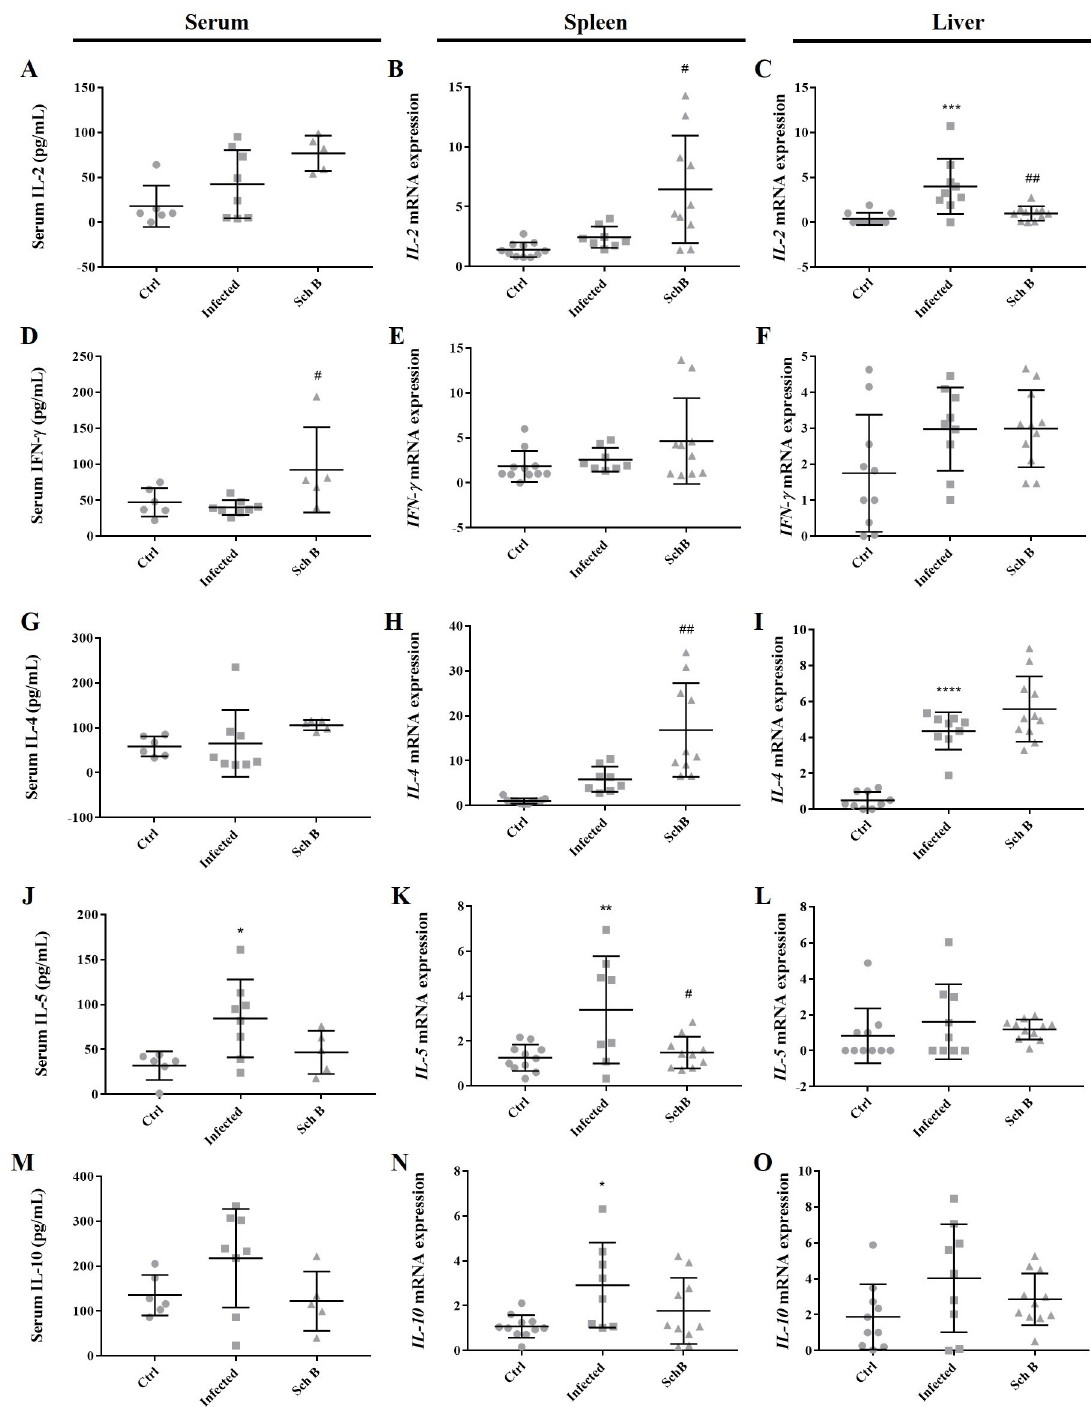
Fig 7. Sch B treatment regulates Th1 and Th2 immune responses in S . mansoni -infected mice. (A, D, G, J, M) Concentrations of IL-2, IFN- γ , IL-4, IL-5, and IL-10 in the serum, measured by ELISA. (B, E, H, K, N) Relative mRNA expression levels of splenic cytokines, measured by qPCR. (C, F, I, L, O) Relative mRNA expression levels of liver cytokines, measured by qPCR. IL-2 and IFN- γ are Th1 cytokines; IL-4, IL-5, and IL-10 are Th 2 cytokines. All results are presented as mean ± S.D. (n = 5–11). � P -value < 0.05, �� P -value < 0.05, ��� P -value < 0.001, and ���� P -value < 0.0001 compared with control group; # P -value < 0.05 and ## P -value < 0.01 compared with infected group.